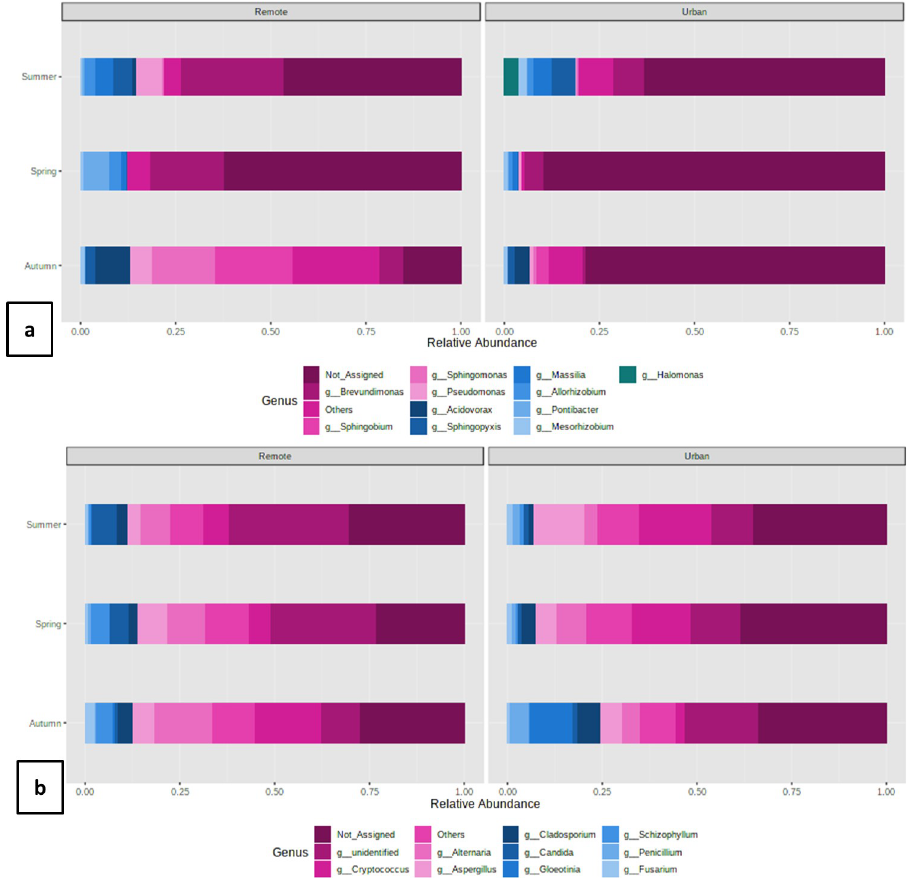
Fig 5. Bar plots representing the seasonal variations in relative abundances of predominant genus of (a) Bacteria and (b) Fungi. The taxa above 100 OTU counts are represented on the plots. The rest are binned together as others.